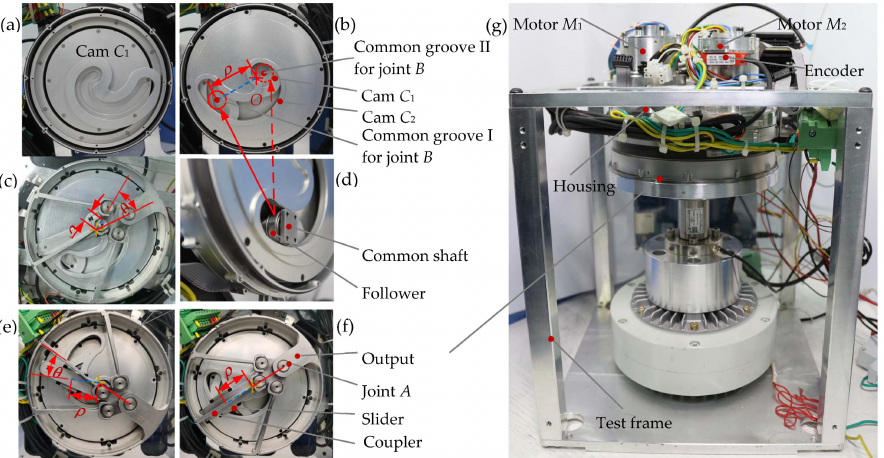
Figure 12. Test platform ( a ) Shape of cam C 1 ( b ) Two different positions of common groove for two reconfigurable configurations of VSA ( c ) Deformed VSA of configuration II ( d ) Structure of cam followers ( e ) Deformed VSA of configuration I ( f ) Undeformed VSA of configuration I ( g ) Overall structure of the test